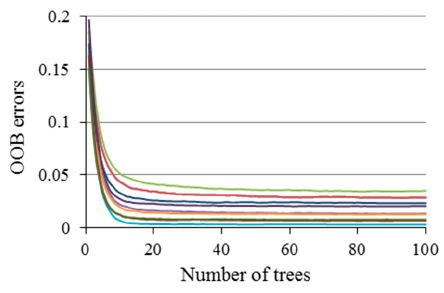
Figure 6. The relationship between the number of trees and OOB errors.